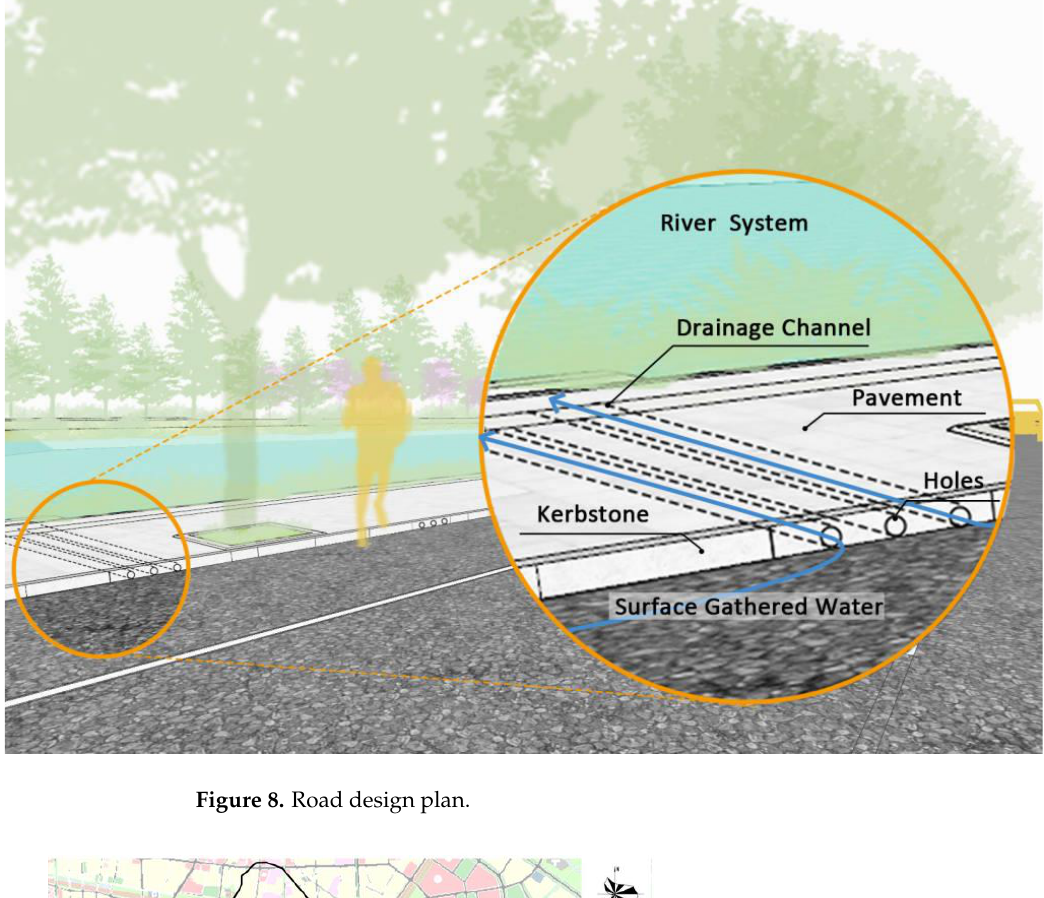
Figure 8. Road design plan.